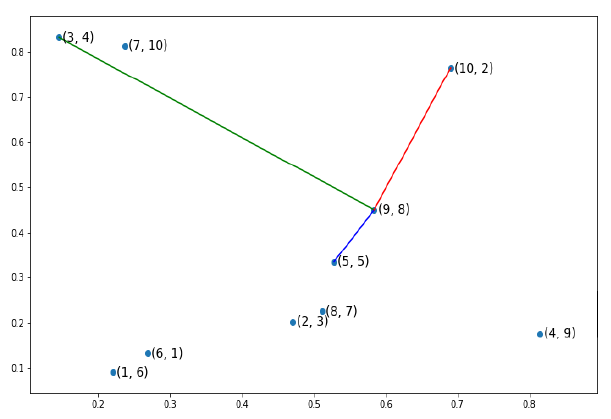
Figure 3. This figure depicts the pertinent distances of a specific gene (gene (9,8)) for a Traveling salesman Problem with 10 cities chromosome. The red vertex depicts the pertinent path between our gene and next gene. The green and blue vertices link the gene of interest with the farthest and closest gene in respect.